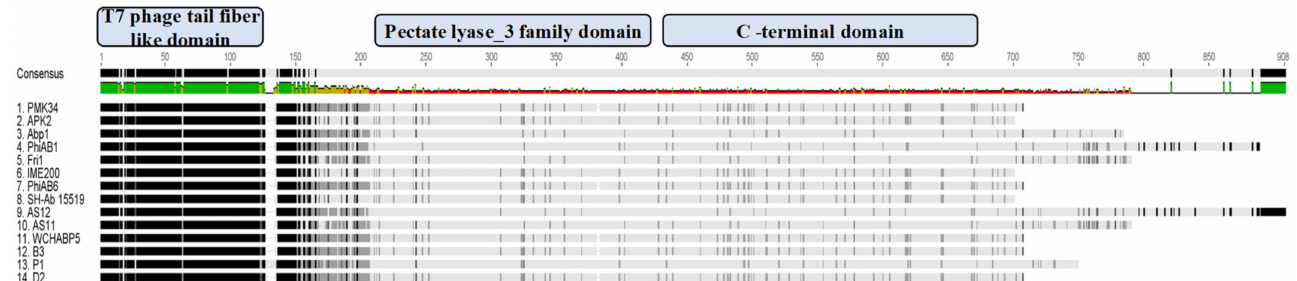
Figure 2. Multiple protein sequence alignment of DpoMK34 and tailspikes of highly ho- mologous phages. Amino acid sequence alignment of phage PMK34 tailspike (DpoMK34) with tailspikes of homologous phages including APK2 (AZU99242.1), Abp1 (YP_008058239), phiAB1(YP_009189380.1), Fri1 (YP_009203055.1), IME200 (YP_009216489.1), phiAB6 (YP_009288671.1), SH-Ab 15519 (YP_009598268.1), AS12 (YP_009599229.1), AS11 (YP_009599281.1), WCHABP5 (YP_009604582.1), B3 (YP_009610379.1), P1 (YP_009610482.1) and D2 (YP_009624618.1) using Geneious ® 7.1.3. Per protein, the darkness per amino acid position indicates the level of simi- larity. The alignment shows a conserved N-terminal T7 phage tail fiber-like domain (amino acids 15 to 110), a variable central pectate lyase domain (amino acids 225 to 433) and variable C-terminal domain (amino acids 434 to 699) for DpoMK34. The amino acid consensus is shown on top with the level of conservation ranging from high to low, ranging from green to red, correspondingly.